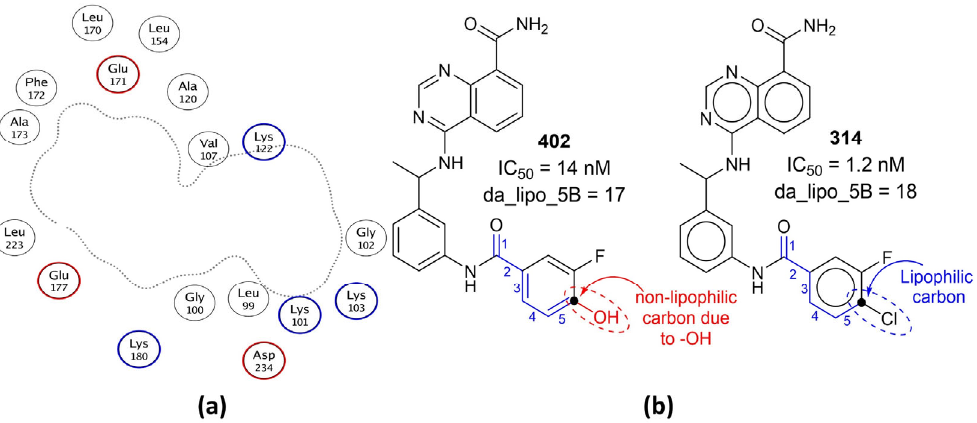
Figure 3. ( a ) A 2D depiction of active site of aurora kinase B (pdb: 4c2w). The dotted line represents the contour proximity of active site residues. Acidic and basic residues have been highlighted using red- and blue-colored circles. ( b ) Comparison of molecule 402 with 314 with respect to da_lipo_5B (blue-colored bonds and